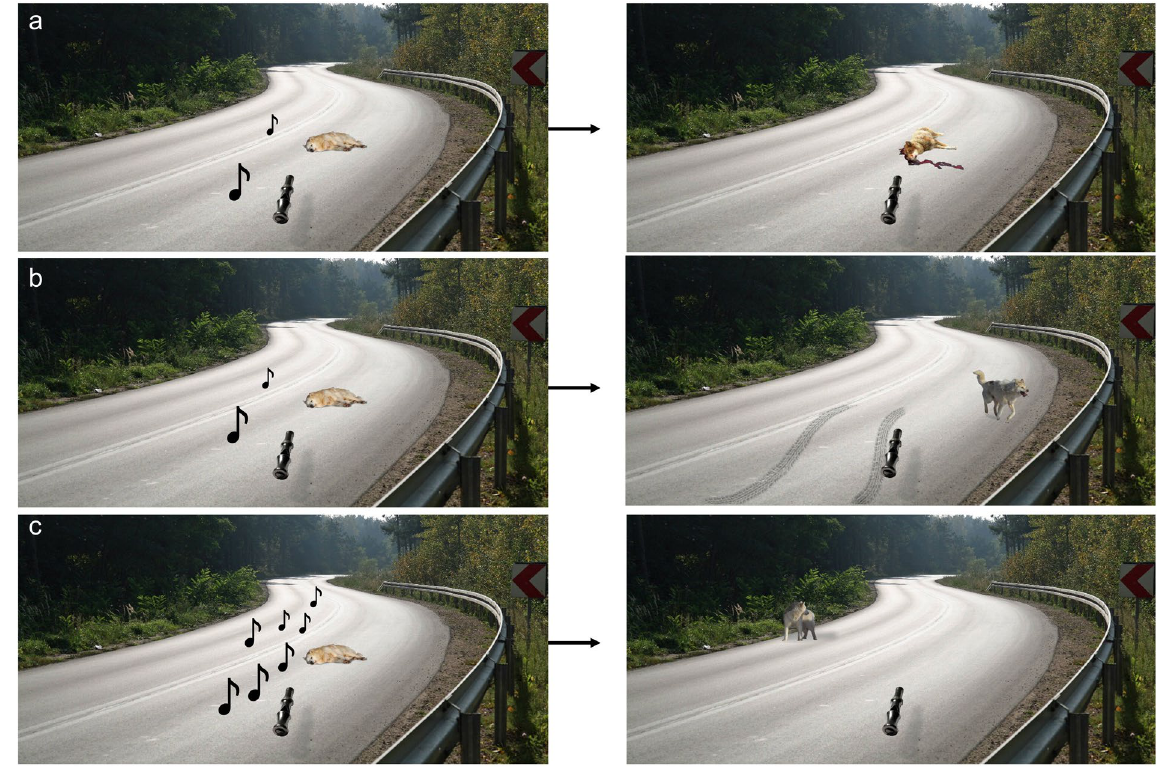
Figure 2. Example trials of main task. Each trial started with a view of the selected dog sleeping in the road; participants could squeeze a grip, producing a number of musical notes on the screen proportional to the strength of the squeeze grip (representing the strength of a dog whistle to wake the dog). ( a ) If insufficient force was exerted, the dog was killed by an oncoming car in 80% of high danger trials and 20% of low danger trials. ( b ) If insufficient force was exerted, the car swerved and the dog survived in 20% of high danger trials and 80% of low danger trials. ( c) If the participant exerted a sustained force (calibrated to their individual grip strength), the trial resulted in the dog being saved. Less effort resulted in proportionally smaller probability of saving the dog. The car was assumed to come from behind the dog on the same side of the road (i.e., originating from beyond the bend in the lower left hand corner of Fig. 2a–c). All participants were UK residents, and were therefore familiar with cars driving on the left side of the road. The following images are reproduced under the terms of a Creative Commons 2.0 generic license (https://creativecommons.org/licenses/by/2.0/ legalcode) and have been adapted from its original form (Original Author: Drew Avery; title: Annual Dog Sled Race). The links to the original images are: https://www.flickr.com/photos/33590535@N06/5391571793/ in/photostream/ https://www.flickr.com/photos/33590535@N06/5391571785/in/photostream/ https://www. flickr.com/photos/33590535@N06/5392045246/in/photostream/. The following image is reproduced under the terms of a Creative Commons Attribution-Share Alike 3.0 Unported license (https://creativecommons. org/licenses/by-sa/3.0/legalcode) and has been adapted from its original form (Original Author Kim Hansen; title: Recently shot Greenland dog upernavik). The link to the original image is: https://commons.wikimedia. org/wiki/File:Recently_shot_Greenland_dog_upernavik_2007-07-02_edited.jpg. The following image is reproduced under the terms of a Creative Commons Attribution-Share Alike 3.0 Unported license (https:// creativecommons.org/licenses/by-sa/3.0/legalcode) and has been adapted from its original form (Original Author: Sebastian Hartlaub; title: Dog ultrasound whistle). The link to the original image is: https://commons. wikimedia.org/wiki/File:Hundepfeife05.JPG. The following image was reproduced under the terms of a Freeimages Content License (Author: http://www.freeimages.com/photographer/jakubson-56068). The link to the original image is: http://www.freeimages.com/photo/double-curves-1448529. The musical note is a Unicode Character, ‘Eighth Note’ (U + 266 A) (The Unicode Standard, Version 1.1.0, (Mountain View, CA: The Unicode Consortium,